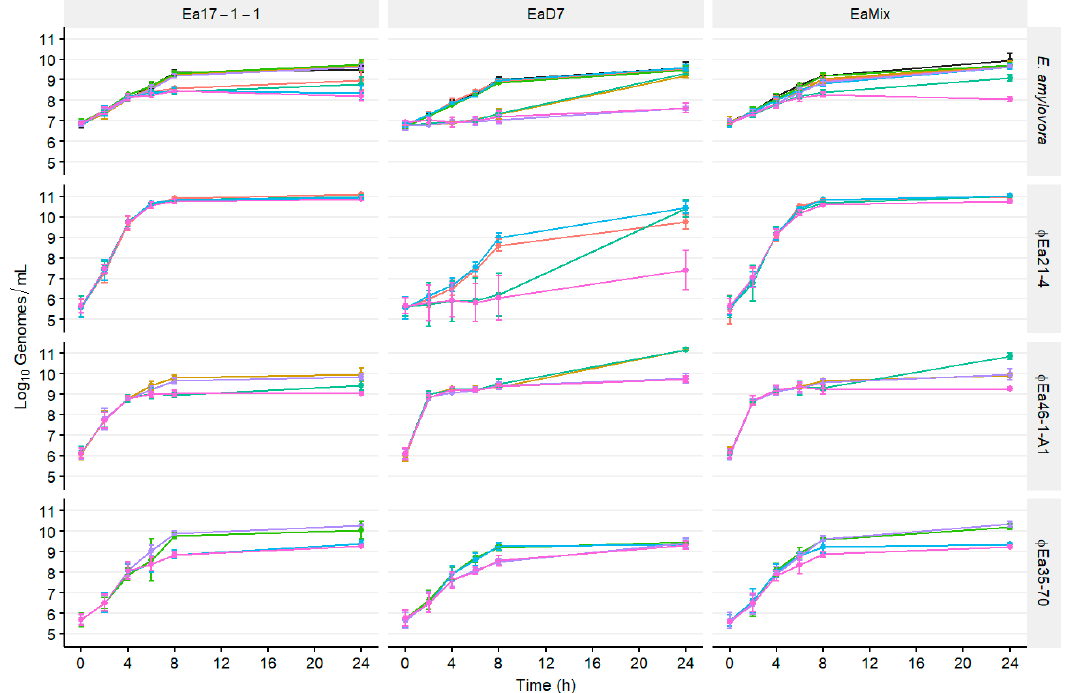
Figure 1. Populations of E. amylovora infected with different phage combinations over time. The infected strains Ea17-1-1, EaD7, and an equal mixture of both (EaMix) are indicated in the top banners. The banners on the right indicate the host or phage quantified. Each host was infected by all possible phage combinations, which are indicated by color: ϕ Ea21-4 ( ● ), ϕ Ea46-1-A1 ( ● ), ϕ Ea35-70 ( ● ), ϕ Ea21-4 + ϕ Ea46-1-A1 ( ● ), ϕ Ea21-4 + ϕ Ea35-70 ( ● ), ϕ Ea46-1-A1 + ϕ Ea35-70 ( ● ), ϕ Ea21-4 + ϕ Ea46-1-A1 + ϕ Ea35-70 ( ● ), no phage ( ● ). Genomic titers of E. amylovora and each phage were determined with qPCR. Data are the mean ± SD of three replicates.